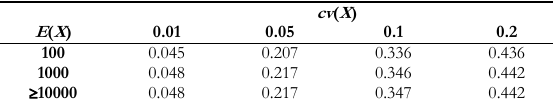
Values of  Ye corresponding to a standardized shift of magnitude | 